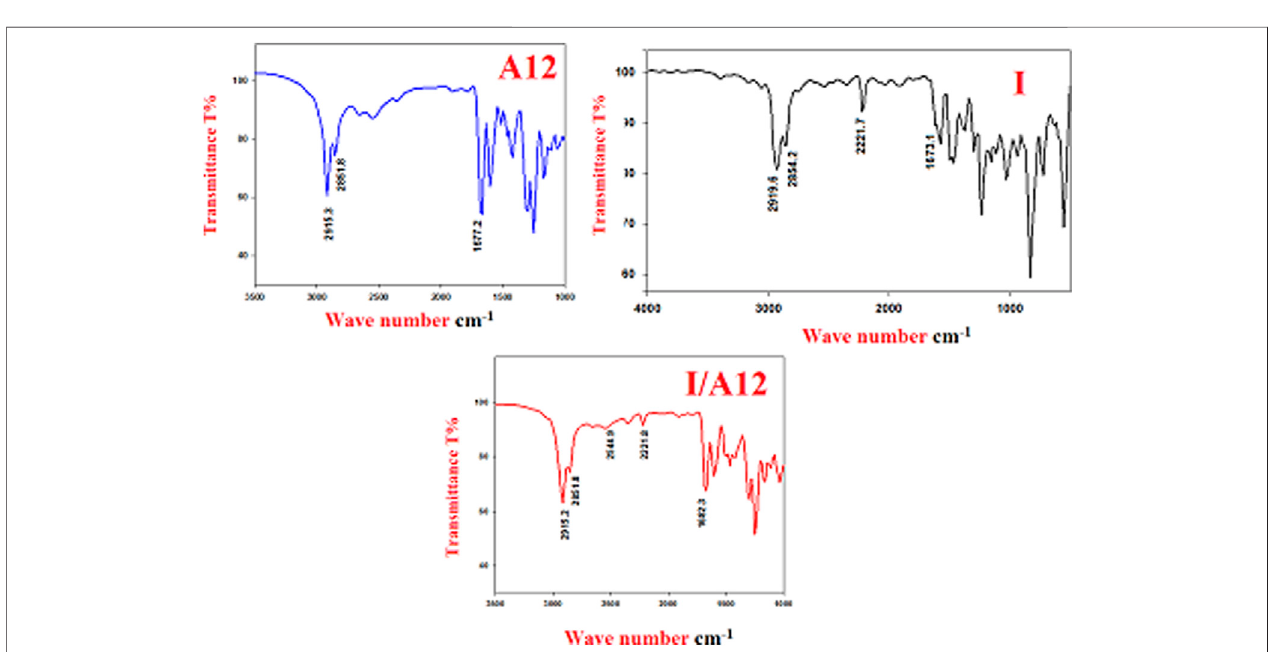
FIGURE 2 | FT-IR 1:1 supramolecular H-bonded complexes (I/A12).